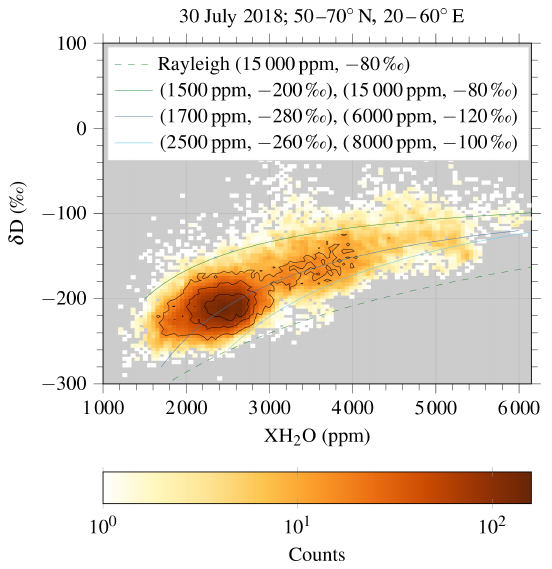
Figure 12. Two-dimensional histogram of all TROPOMI obser- vations in the 50–70 ◦ N, 20–60 ◦ E area on 30 July 2018 (colour- coded). The black contours show the 25%, 50% and 75% lev- els of the cumulative density. The dashed green curve represents a Rayleigh fractionation process, and the solid green, blue and cyan curves represent idealised mixing processes as specified by the leg-